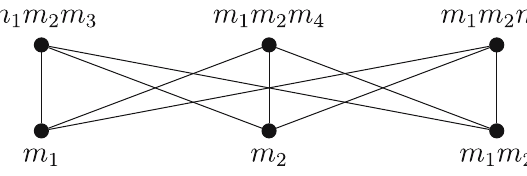
Figure 3: ( ) S PDG contains K 3,3 as a subgraph for ≥ n 5